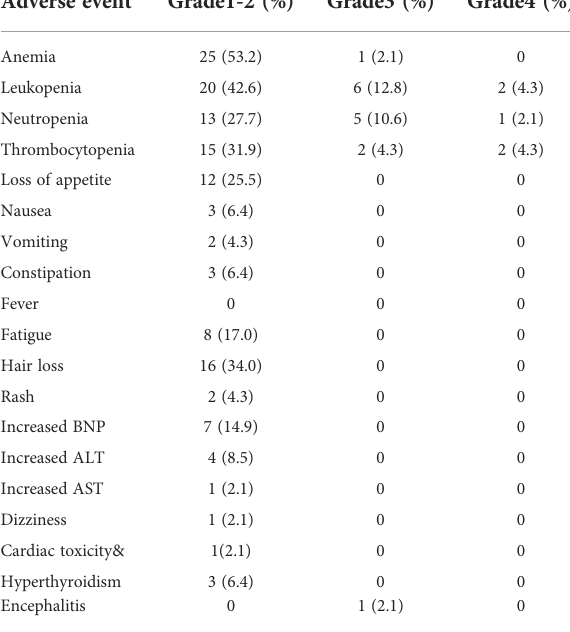
TABLE 2 Adverse Events (N=47 cases).